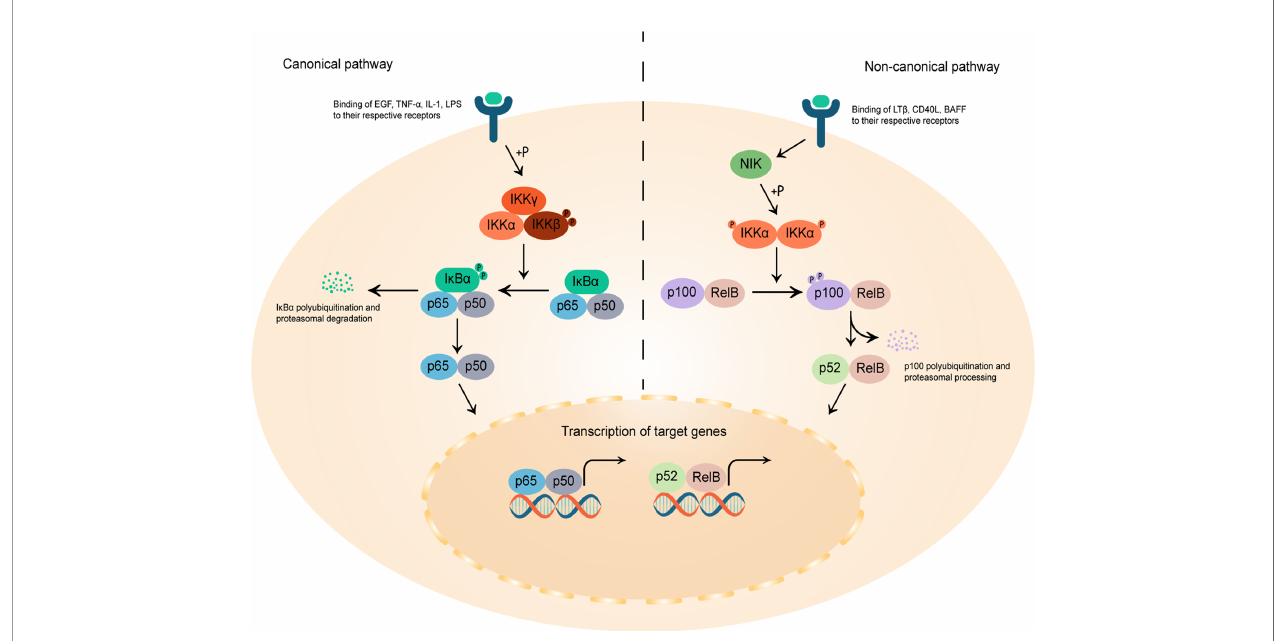
FIGURE 3 | Schematic diagram of the canonical and non-canonical NF- k B signaling pathway. In the canonical pathway, on the left, the binding of epidermal growth factor (EGF), tumor necrosis factor- a (TNF- a ), interleukin-1 (IL-1) and lipopolysaccharides (LPS) to their respective receptors lead to the phosphorylation of inhibitor of k B (I k B)-kinase b (IKK b ) in the IKK complex, which in turn phosphorylates I k B a , culminating in its polyubiquitination and proteasomal degradation. The free NF- k B homo- or heterodimers, in this case p65/p50, then translocate into the nucleus to bind to k B motif and promote target gene transcription. The non-canonical pathway, on the right, is activated by the binding of lymphtoxin b (LT b ), CD40 ligand (CD40L), and B-cell activating factor (BAFF) to their respective receptors, causing IKK a dimers phosphorylation by the NF- k B-inducing kinase (NIK). Phosphorylation of p100 by activated IKK a initiates proteasomal processing of p100 N- terminal to form p52. The p52/RelB heterodimers can then undergoes nuclear translocation and modulates the gene transcription of pro-in fl ammatory cytokines in a feedback-loop